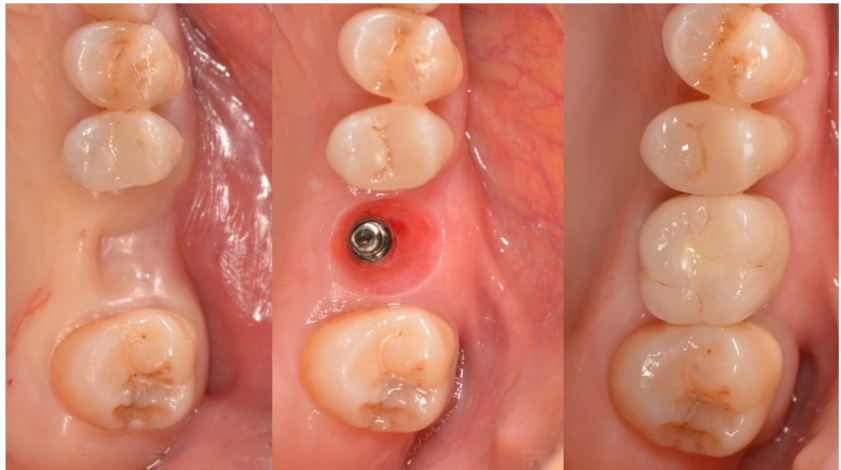
Figure 11. Baseline, after conditioning and final